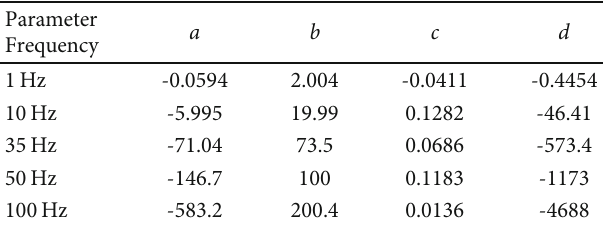
Figure 12: (a) z -direction force on the dorsal fi n at di ff erent frequencies. (b) The relationship between amplitude of force and frequency. (c) The relationship between average value of force and frequency. Table 6: z -direction force parameter values of the dorsal fi n at di ff erent